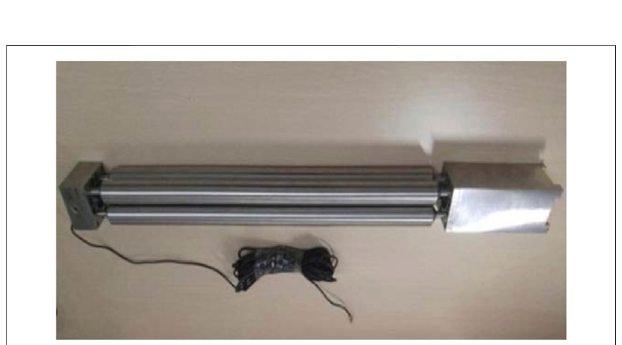
FIGURE 2 | schematic diagram of mock-up reactor (top view).